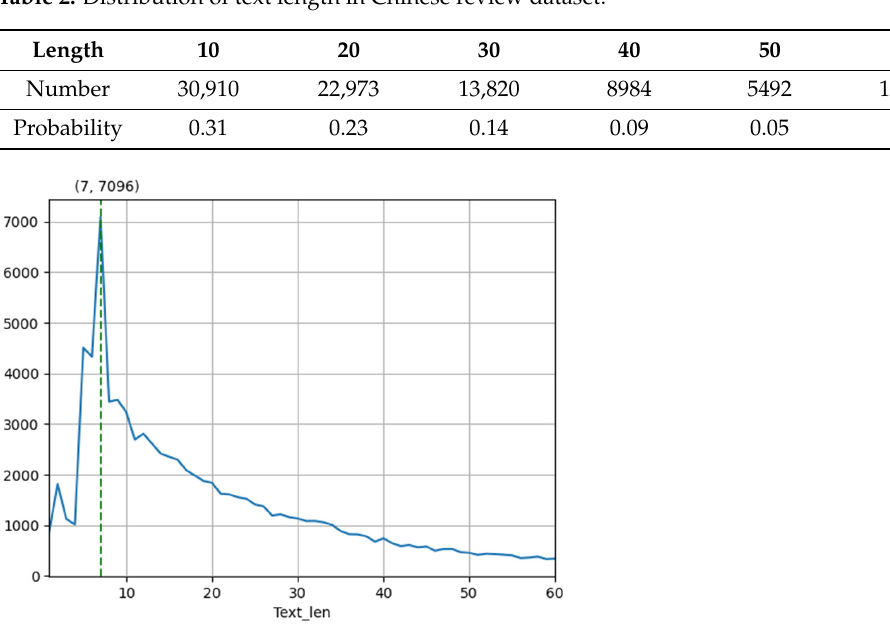
Table 2. Distribution of text length in Chinese review dataset.